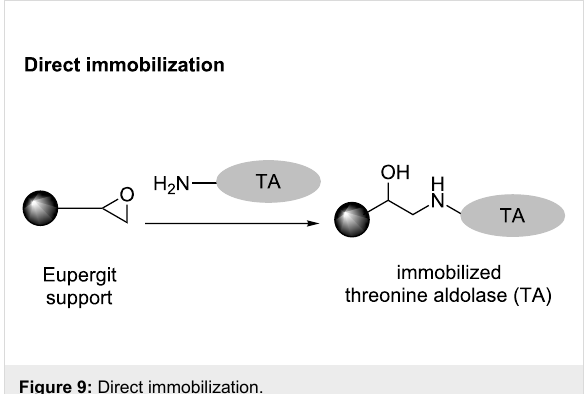
Figure 9: Direct